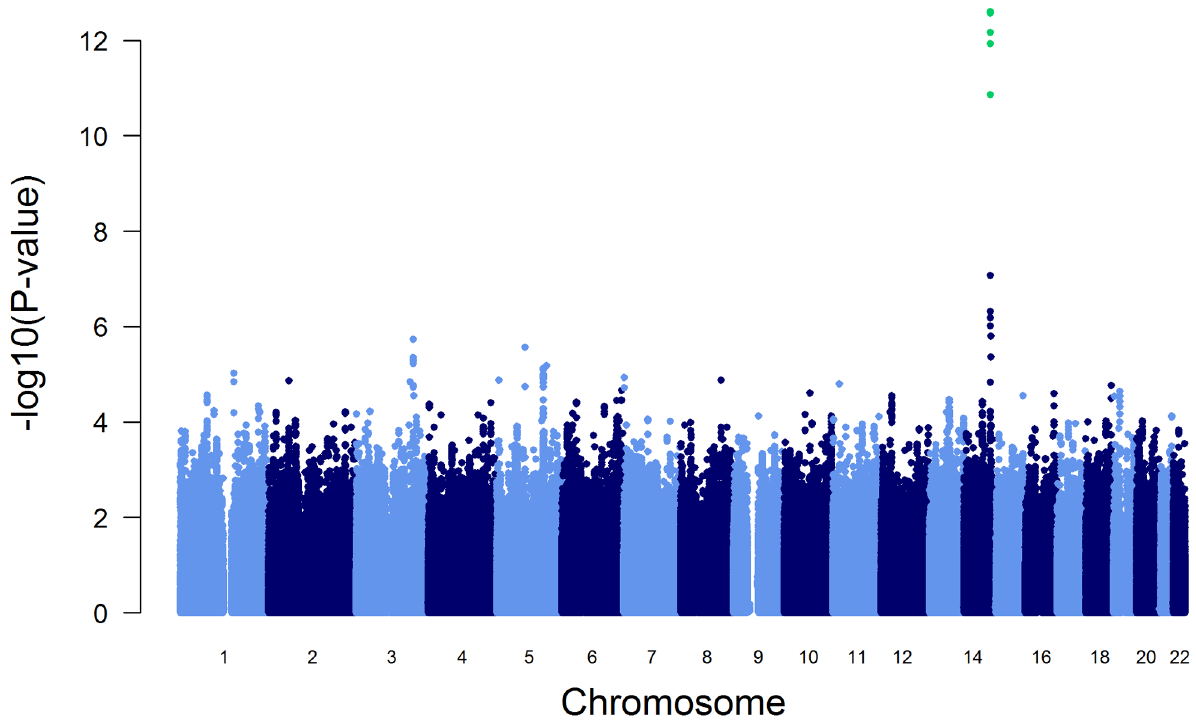
Figure 1. Manhattan plot of genome-wide -log(10) p-values for association with AAT serum level. SNPs reaching genome-wide significance are shown in green. They all belong to the SERPINA gene cluster.